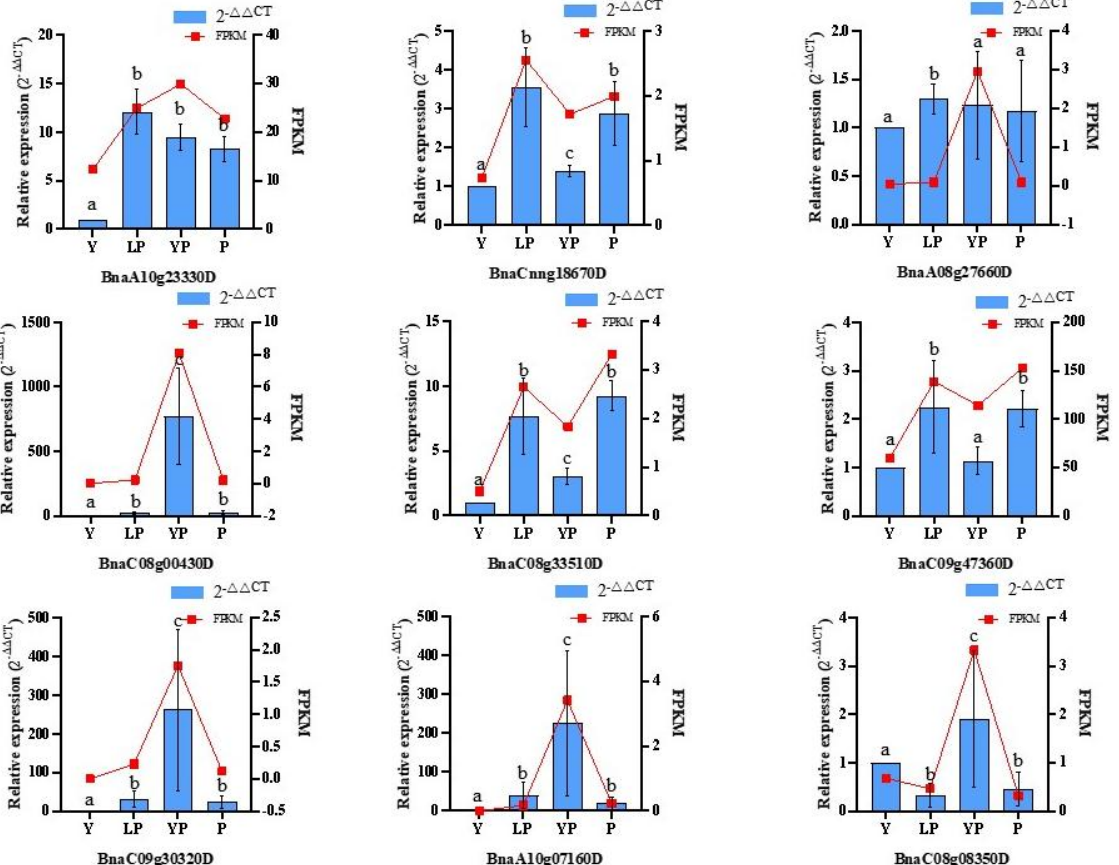
Figure 11. qRT-PCR analysis of selected DEGs in the rapeseed petal subtypes, identi fi ed by tran- scriptome analysis. Note: Y represents a yellow petal line; LP represents a light purple petal line; YP represents a yellow/purple petal line; P represents a purple petal line. BnaA10g23330D : BnF3 ʹ H ; BnaCnng18670D: BnVSR ; BnaA08g27660D and BnaC08g00430D : BnHCT ; BnaC08g33510D : BnFLS ; BnaC09g47360D: BnF3H ; BnaC08g08350D , BnaC09g30320D and BnaA10g07160D : BnUFGT . Fold Change: Take Y as the reference point. Internal reference gene: β -actin. Data are means ± SD obtained from three biological replicates. Di ff erent le tt ers above the error bars indicate signi fi cant di ff erences at p < 0.05, according to Tukey’s test.